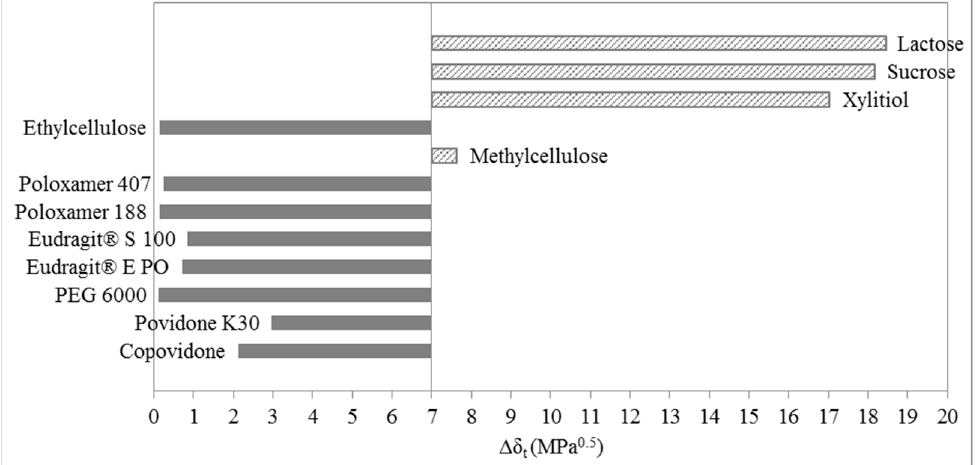
Figure 6. Bar graph for ibuprofen solubility according to Greenhalgh.